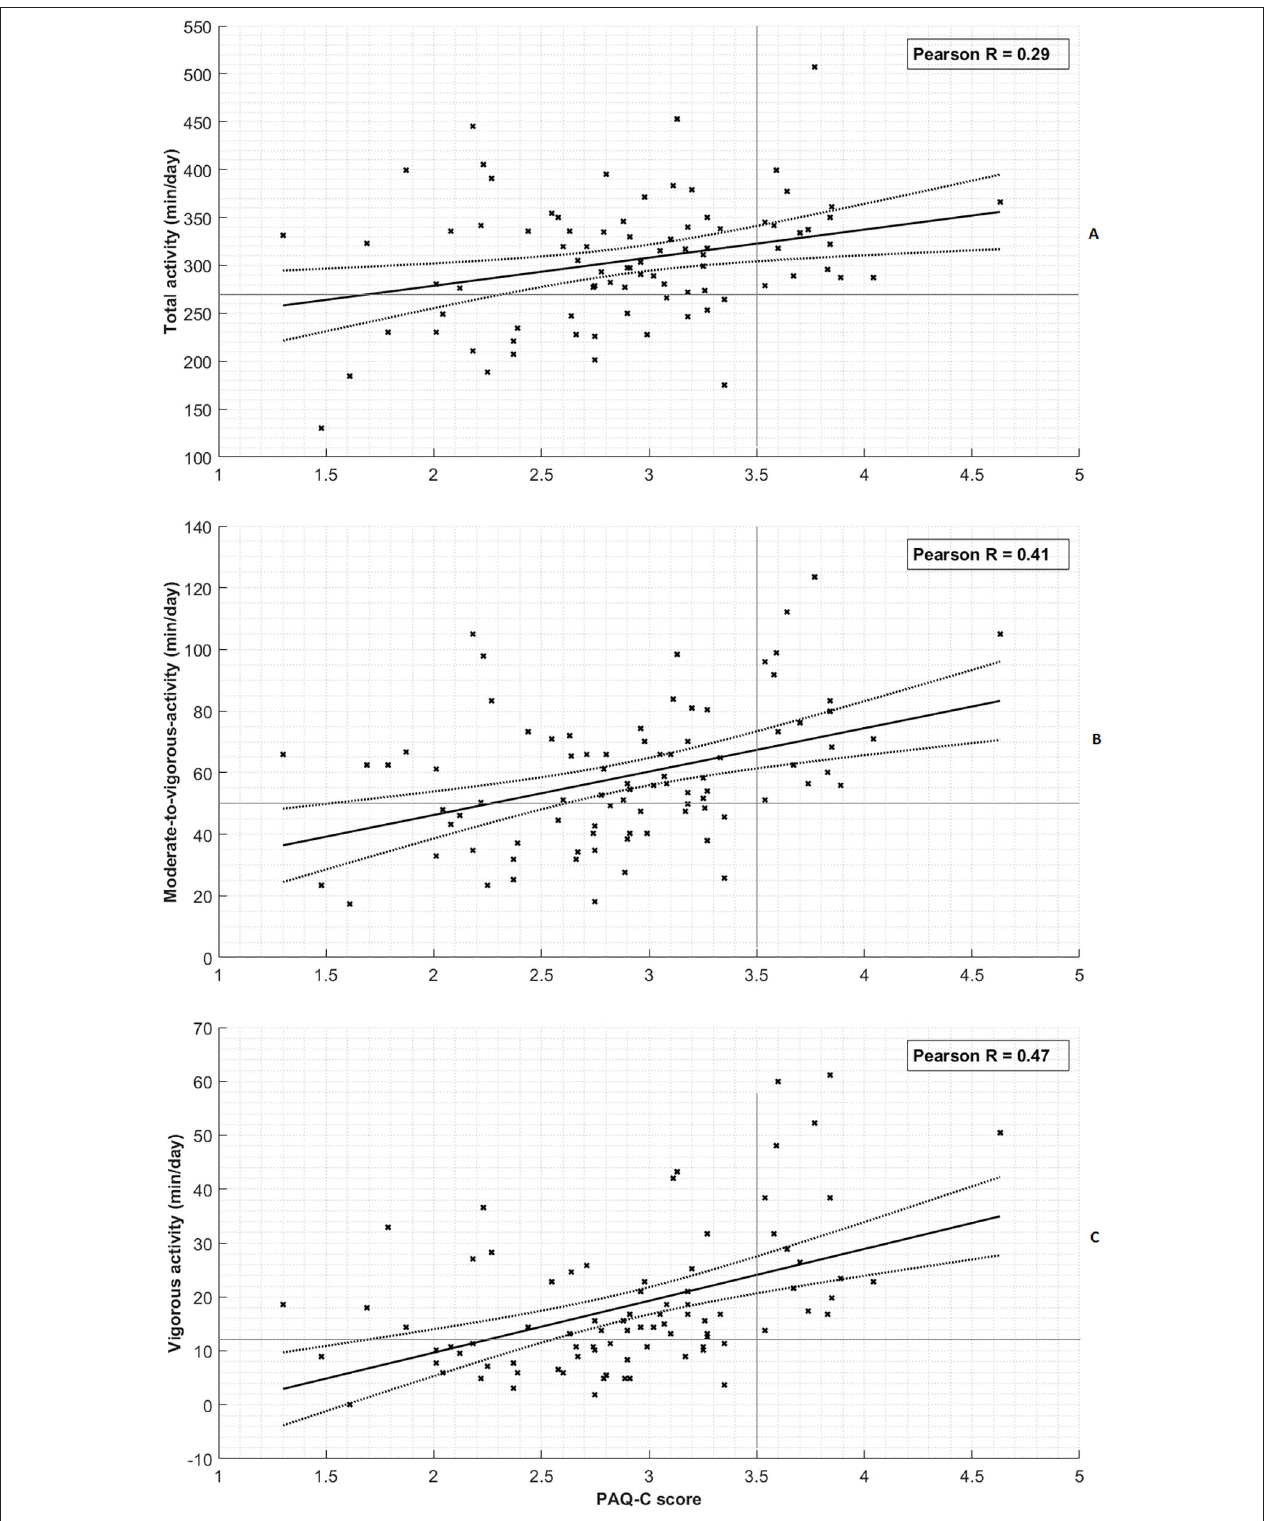
FIGURE 1 | Correlation of physical activity measures with PAQ-C score. (A) Total activity. (B) Moderate-to-vigorous activity. (C) Vigorous activity. Each cross represents a single subject measurement. The thick black line represents the linear regression line and the dashed line denotes its 95% confidence interval. The horizontal and vertical thin gray lines provide an indication of the distinctive character of the PAQ-C threshold of 3.5 for assessing inactivity.